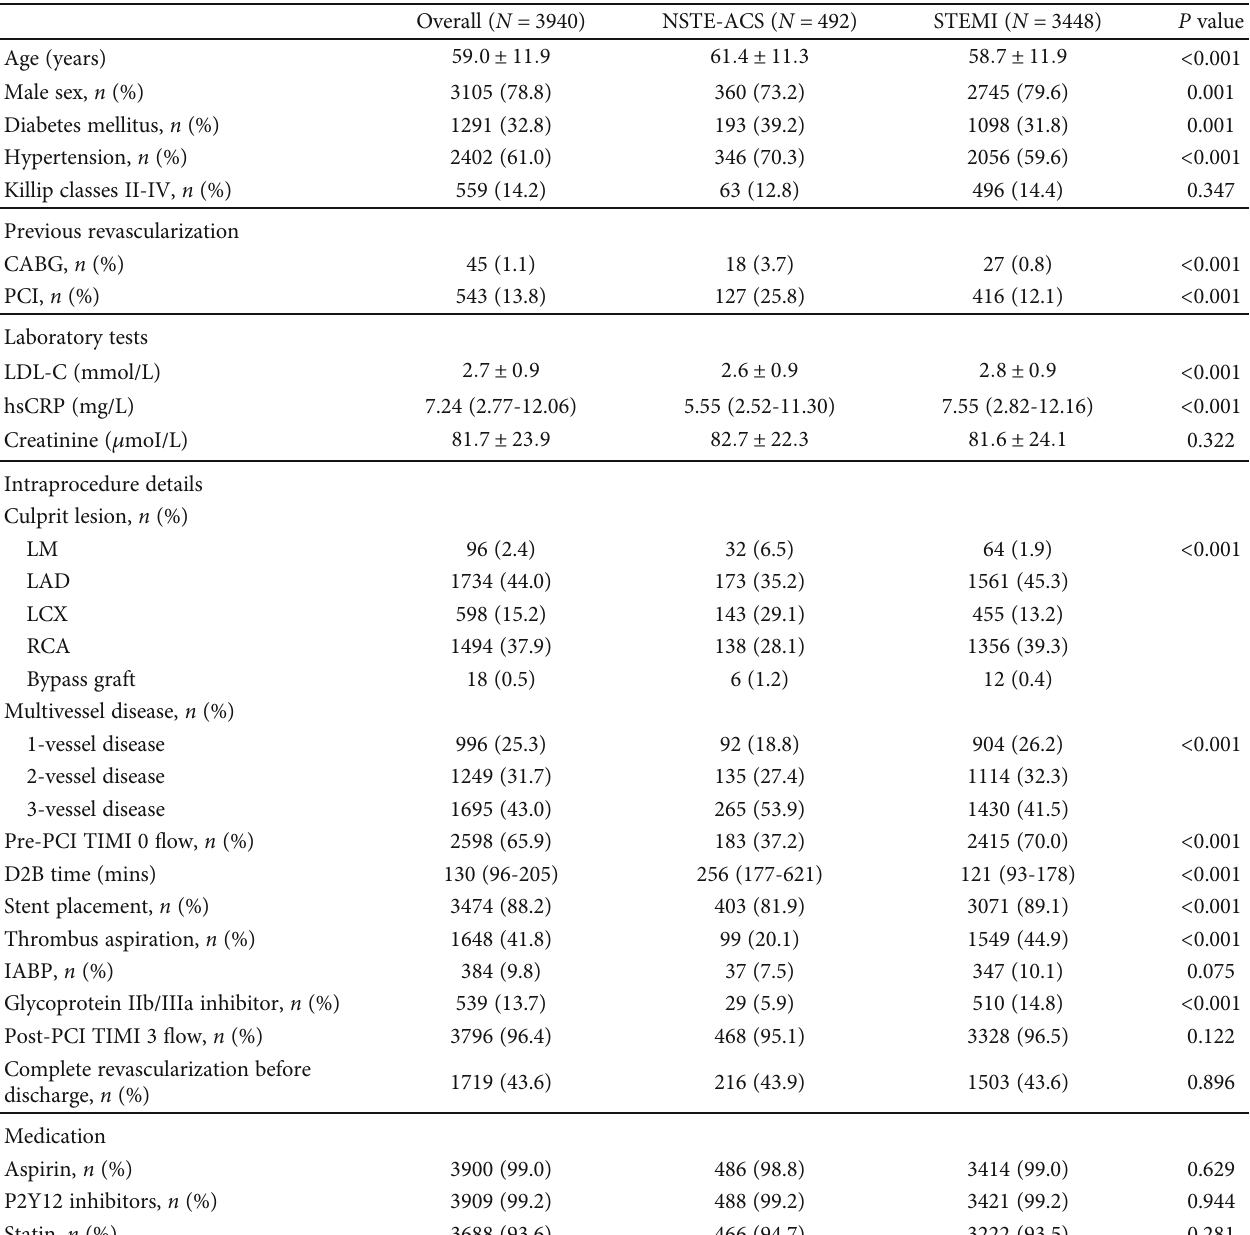
Table 2: Baseline characteristics of patients by classi fi cations of acute coronary